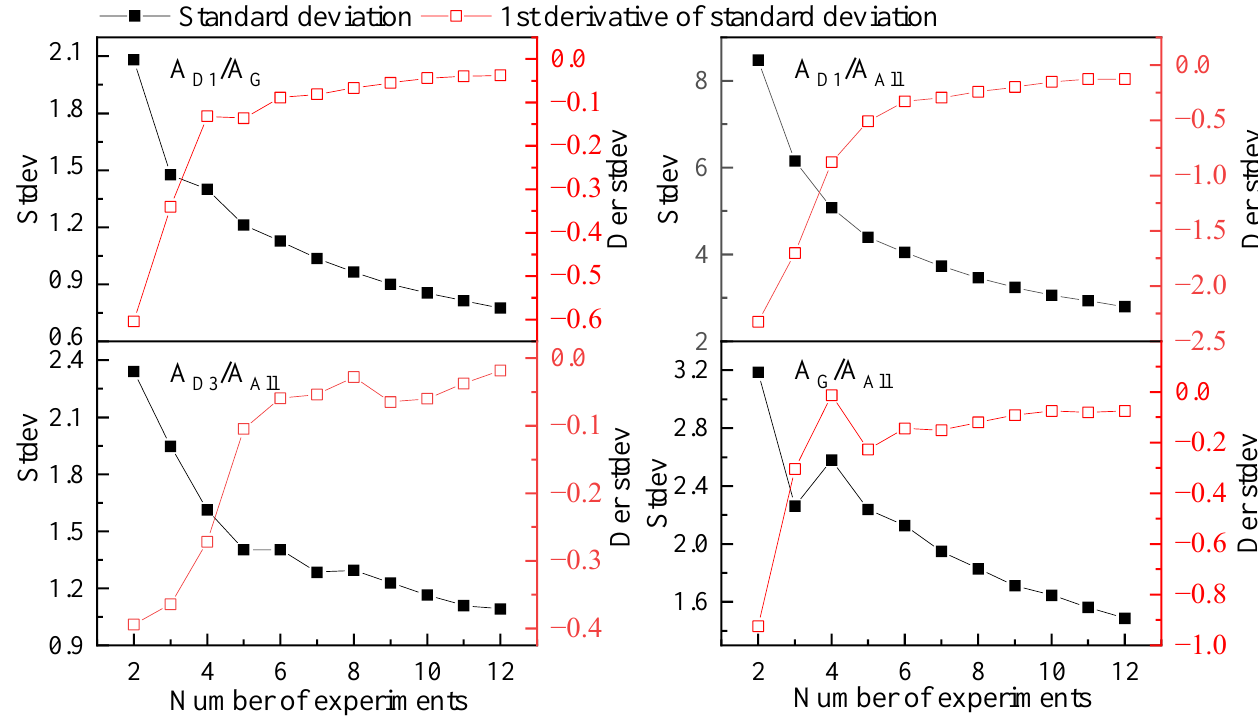
Figure 7. Standard deviations and corresponding derivatives of char1 Raman characteristic parameters.